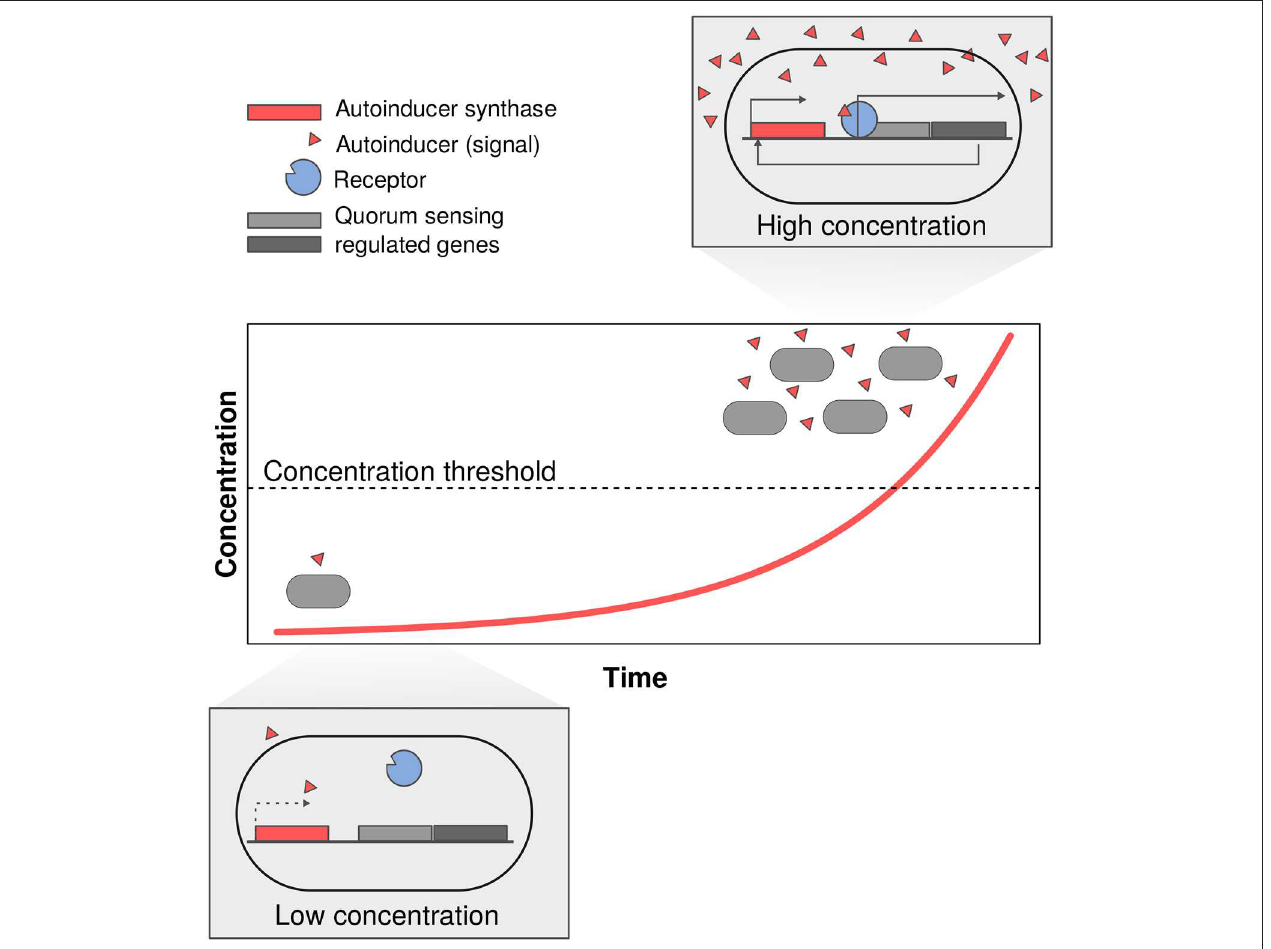
FIGURE 2 | Quorum sensing is a system of communication that relies on the concentration of an autoinducer. In this system bacteria are constantly producing a small amount of signal (autoinducers; red triangles). As bacteria reach a larger density the concentration of autoinducer increases until it crosses a threshold after which it binds to the receptor and induces changes in expression. This changes often lead to an increase expression of autoinducer and thus act as positive feedbacks in high concentration of